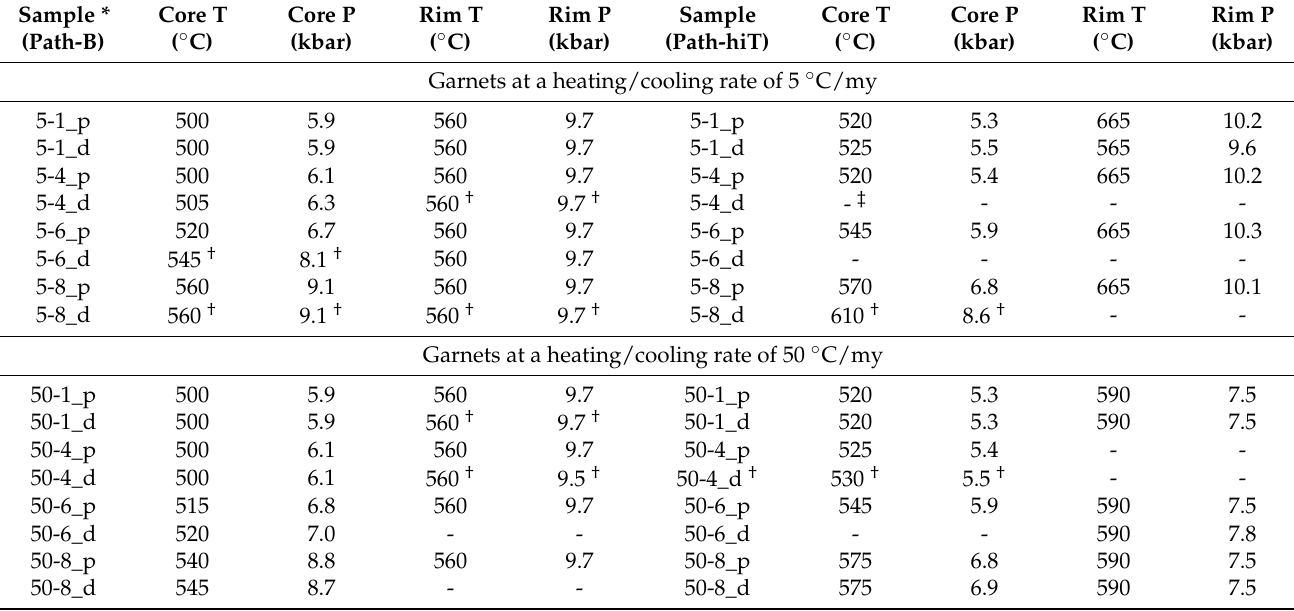
Table 2. Garnet core and rim P-T conditions estimated by isopleth